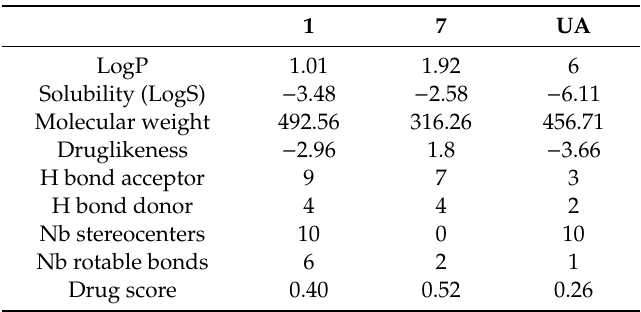
Table 6. Physicochemical properties of compounds 1 , 7 and UA